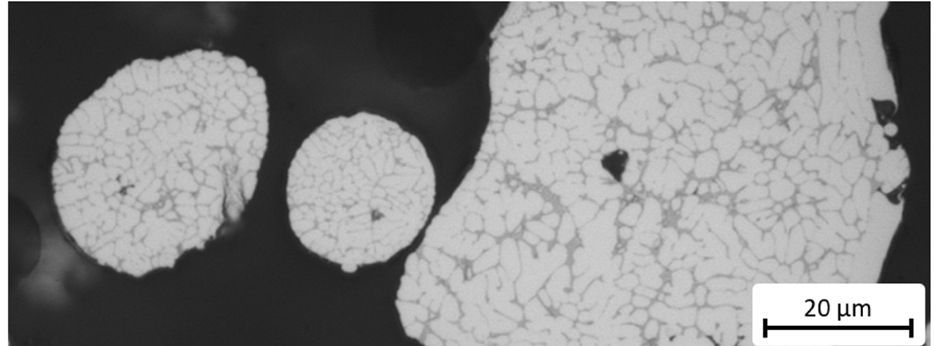
Figure 6. Gas-atomized powder particles of different sizes. The lower the diameter of the powder particles, the finer the dendritic microstructure. Due to their lesser volume, the cooling rate in smaller particles is higher and the crystallization is faster, which results in finer microstructures.